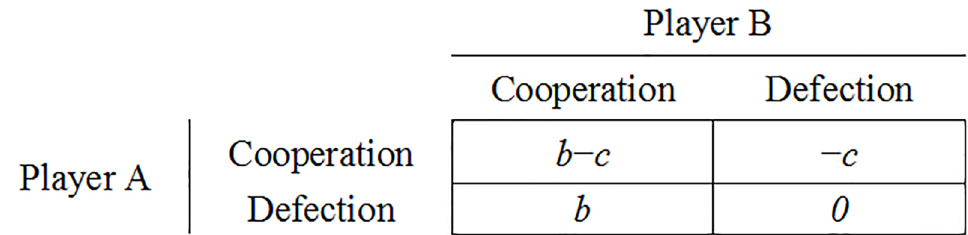
Fig 1. Payoff matrix of the “donation game”. The entries in the matrix refer to the payoffs of player A. The benefit of cooperation ( b ), the cost of cooperation ( c ), and b − c are greater than 0.